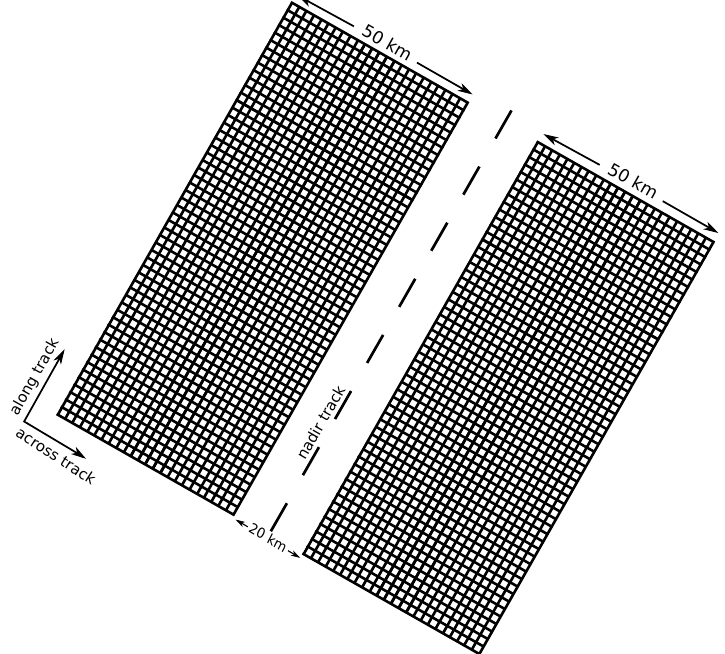
Figure 2. A schematic representation of the SWOT grid at a 2-km